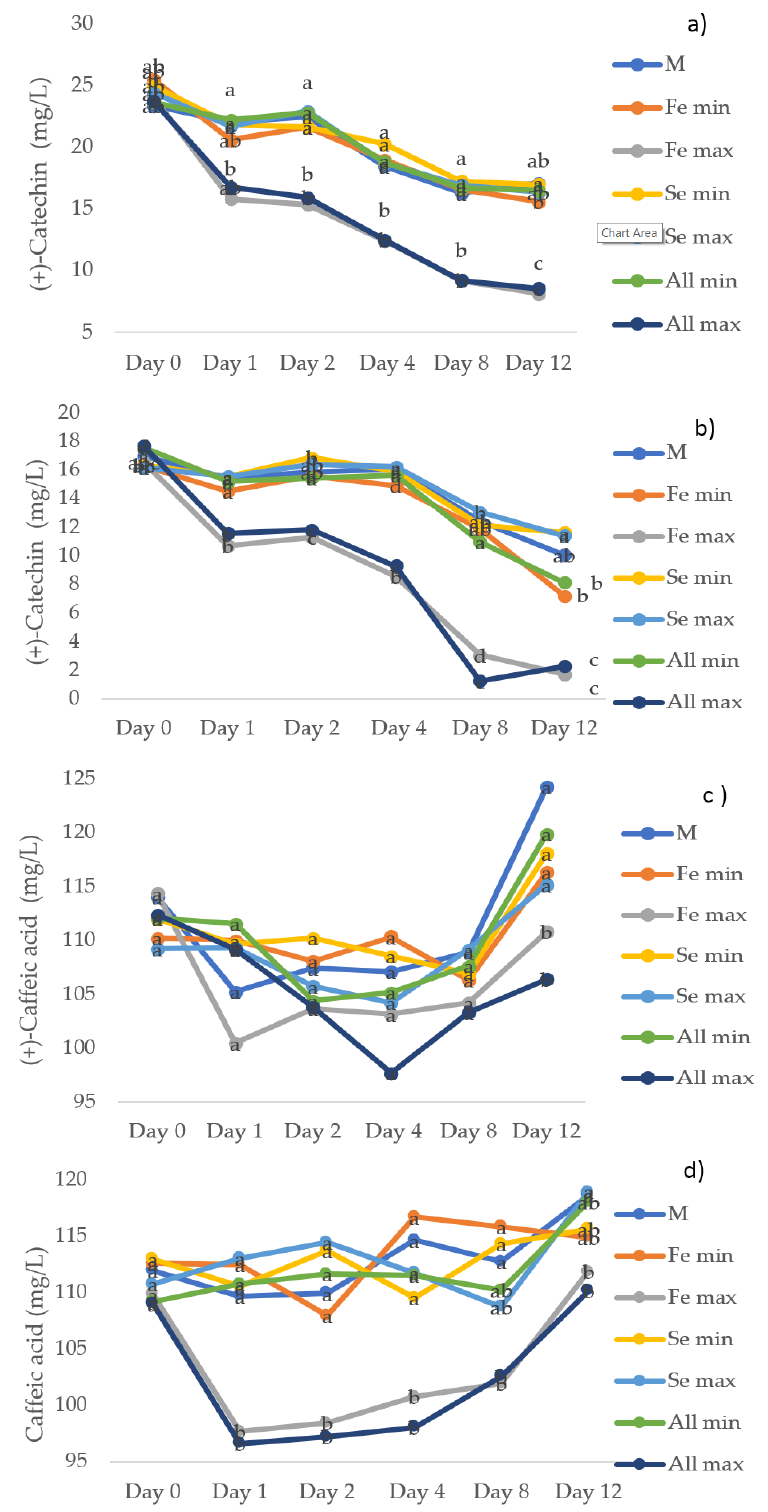
Figure 4. Change of total flavanol (mg/L (+)-catechin) ( a , b ) and total hydroxycinnamic (mg/L caffeic acid) ( c , d ) contents of the samples during 12 days of heating at 35 and 50 ◦ C, respectively. Different letters at each temperature studied indicate statistically significant differences ( p < 0.05). Sample codes are described in Table